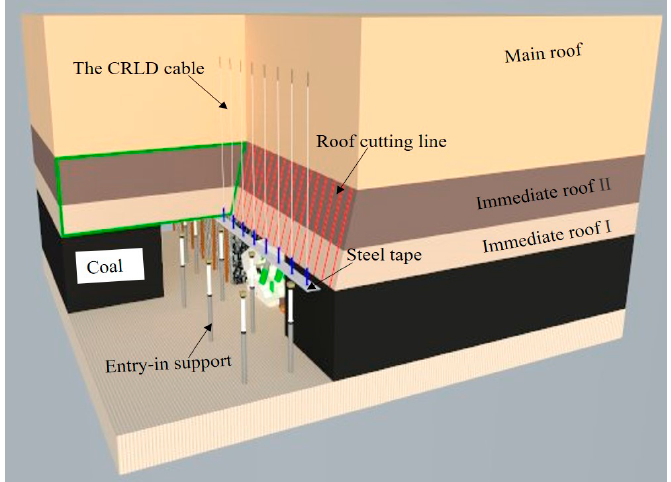
Figure 6. Three-dimensional schematic diagram of the FRME.